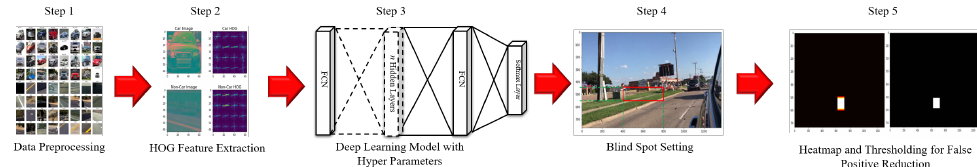
Figure 9. Overall research framework. A total of 2000 vehicle images and approximately 9000 non-vehicle images were extracted for the purpose of data preprocessing. The HOG descriptor was applied for feature extraction, and 1188 HOG features for both vehicle and non-vehicle objects were fed into the FCN model as inputs. Keep in mind that representation or feature learning was not applied in this research due to hardware constraints. Two hidden layers, 1 × 10 − 6 learning rate, and 10 epochs with Adam optimizer and ReLus activation were employed for training and testing the FCN model, and the training and testing accuracies achieved were 99.4% and 99.0%, respectively. We set a blind spot to a range of 400–800 px in x-axis and 450–550 px in y-axis in the 1300 px × 800 px image and applied the sliding window technique to detect vehicle features. Finally, the heat map and thresholding were employed to reduce false positive